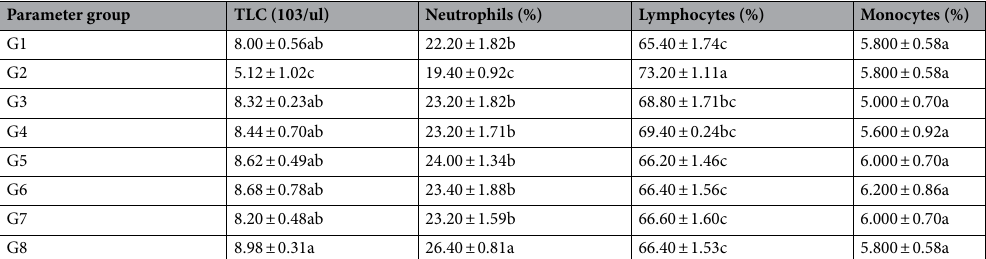
Table 4. Leukogram changes in the blood of normal control and different treated rat groups. G1 = control group, G2 = Paracetamol, G3 = Silymarin + Paracetamol, G4 = Chlorella vulgaris + Paracetamol, G5 = Chlorella vulgaris + Thiamine + Paracetamol, G6 = Silymarin, G7 = Chlorella vulgaris and G8 = Chlorella vulgaris + thiamine. TLCs = Total leukocyte counts. Data are presented as means ± SEM (n = 6). Values having different superscripts within same column are significantly different ( p <